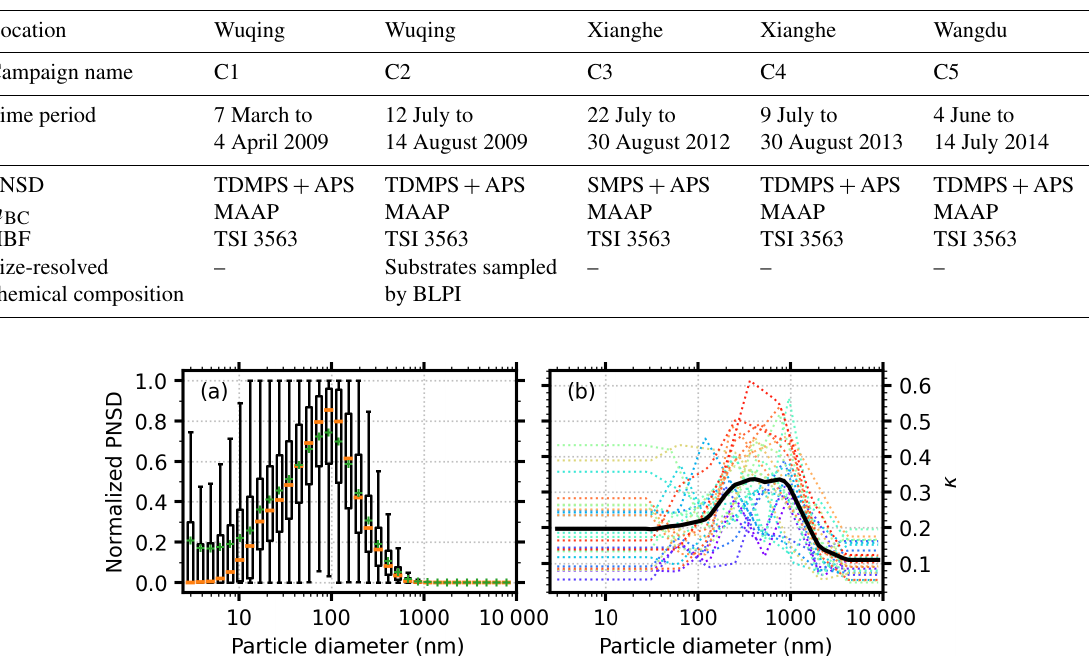
Figure 1. (a) Box plot of particle number size distributions (PNSDs) in the datasets from five field campaigns. Each PNSD is normalized by its maximum value at the peak diameter. Green markers “ + ” represent the mean value of each diameter. The boxes extend from the lower to upper quartile values, with orange lines at the median. The whiskers extend from the box to the minimum–maximum values or extend from the box by 1.5 times the interquartile range. The flyers are not shown in the plot. (b) A total of 25 typical size-resolved κ distributions. Each dotted line with color represents one size-resolved κ distribution. The solid black line represents the mean value of the size-resolved κ